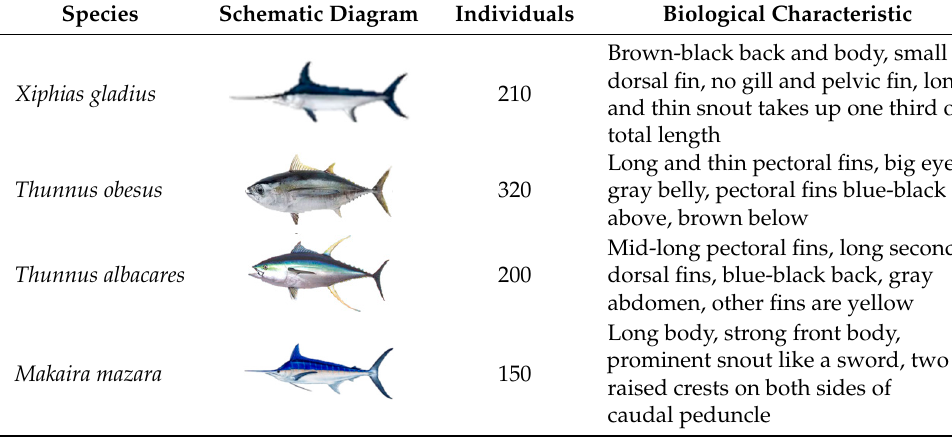
Table 1. Biological characteristic information of four species.